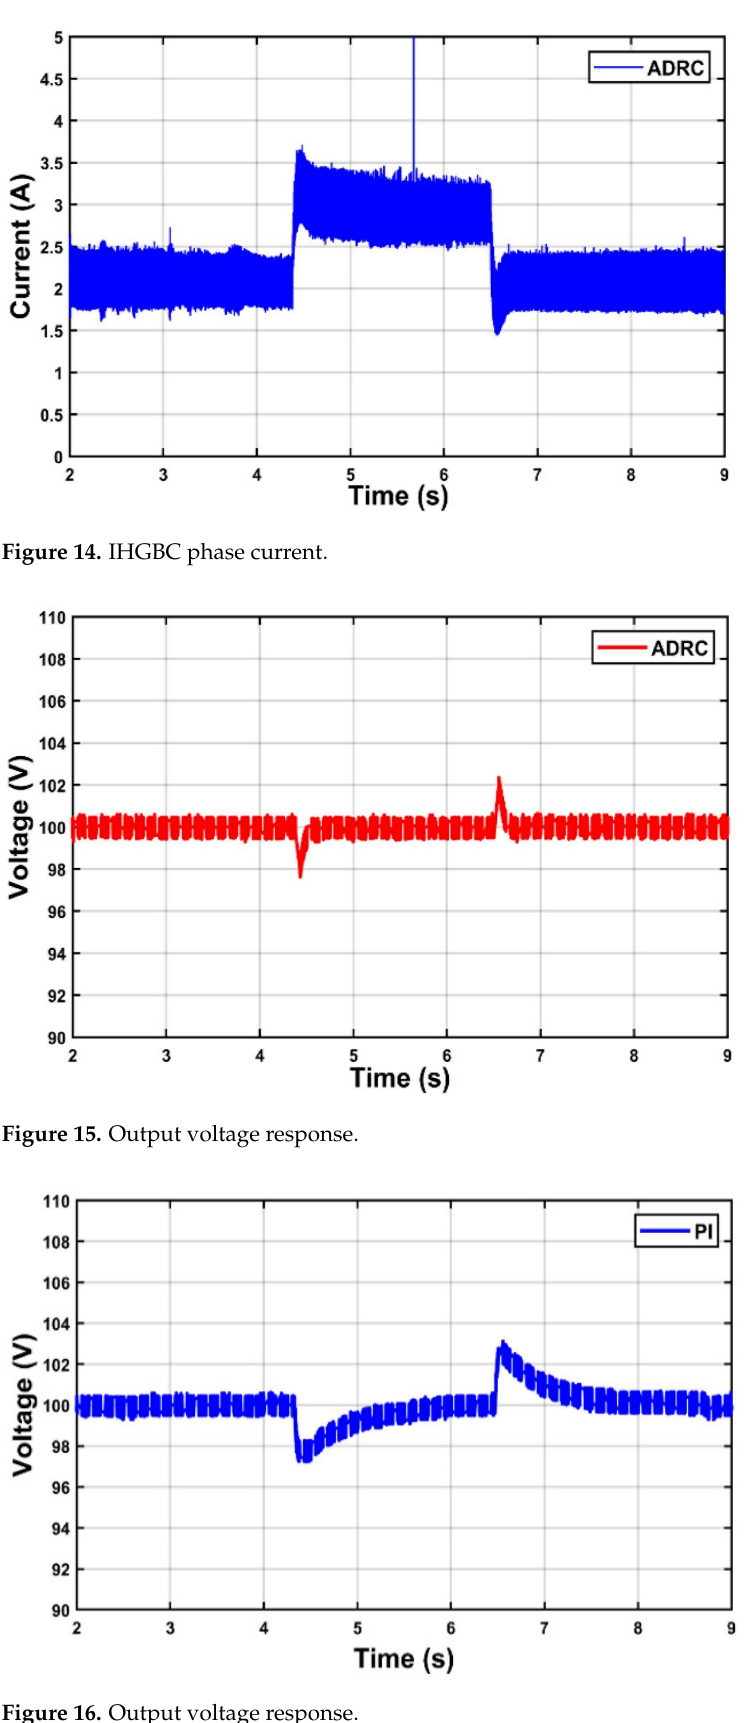
Figure 17. PEMFC emulator’s current and voltage. 7. Conclusions To improve the control performance and ensure the stability and fast response of the DC/DC boost converter under parameter uncertainties and disturbances, a robust two- loop control based on a linear active disturbance rejection control is proposed in this pa- per. It includes an internal current control loop and an external voltage control loop of an interleaved high gain DC/DC boost converter associated with the proton exchange mem- brane fuel cell system. This converter provides high efficiency and high voltage gain with reduced voltage stress on the switches and diodes. In addition, the interleaving technique and the parallel structure of the converter guarantee low input current ripple and reduce the size of the passive components and its modularity also offers fault tolerant capabilities. The robustness and effectiveness of the proposed controller have been confirmed by simulations and experimental results. The results showed that the proposed control unit provides good dynamic performance and stability under different operating conditions. Moreover, the performance of the proposed control still needs to be verified against other advanced control techniques. Additionally, a number of ongoing research studies show that strong robustness can be provided by relying on a hybrid control between LADRC and other control algorithms, and this will be one of the directions of our future research. Author Contributions: Conceptualization, A.A.S.; methodology, A.A.S.; software, A.A.S., F.K. and A.B.; validation, A.A.S. and F.K.; formal analysis, A.A.S. and F.K.; investigation, A.A.S., M.B. and Y.A.; resources, M.B. and Y.A.; data curation, A.A.S. and F.K.; writing—original draft preparation, A.A.S.; writing—review and editing, A.A.S., K.F., Y.A., A.B. and M.B.; visualization, A.A.S., F.K. and A.B.; supervision, M.B. and F.K.; project administration, M.B. and Y.A. All authors have read and agreed to the published version of the manuscript. Funding: This research received no external funding. Institutional Review Board Statement: Not applicable.